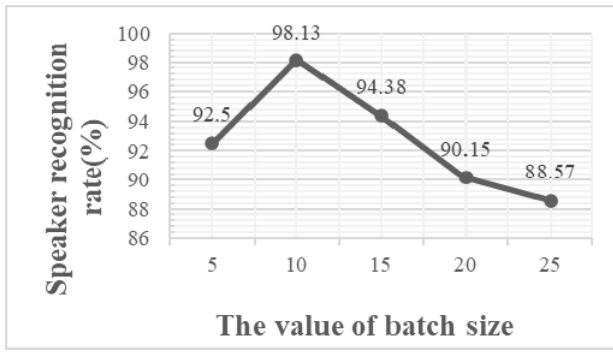
Figure 6. Speaker recognition rate with different learning rate.